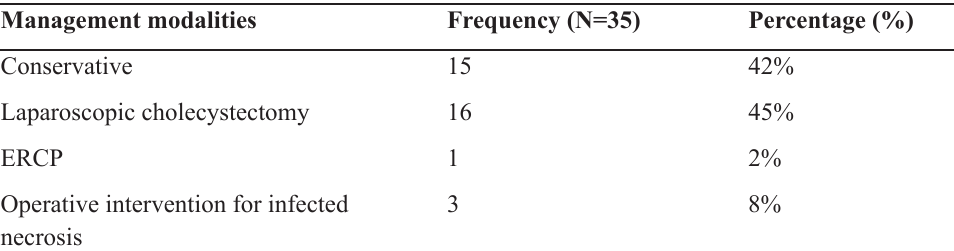
Table 3: Management strategies according to step-up approach for infected pancreatic necrosis Case